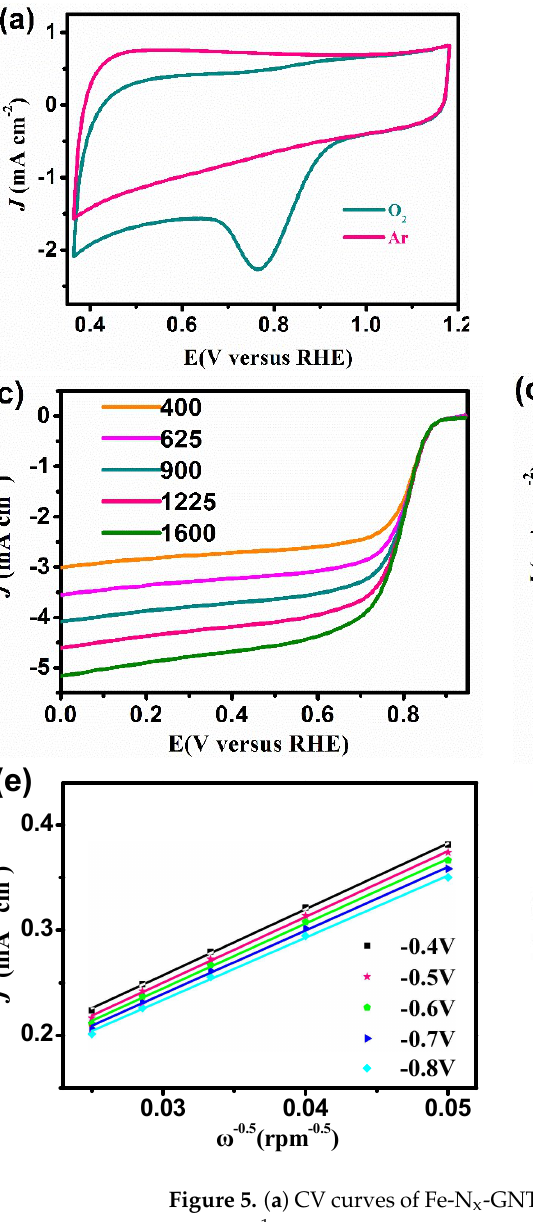
Figure 5. ( a ) CV curves of Fe-N x -GNT-2-1000 in Ar, O 2 -saturated 0.1 M KOH solution at a scan rate of 10 mV s − 1 . ( b ) LSV curves of Fe-N x -GNT-800, Fe-N x -GNT-900, Fe-N x -GNT-1000, Fe-N x -GNT-2-1000 and Pt/C 20% in O 2 -saturated 0.1 M KOH solution at a scanning rate of 10 mV s − 1 with 1600 rpm. ( c ) LSV curves for Fe-N x -GNT-2-1000 in O 2 -saturated 0.1 M KOH solution at a scanning rate of 10 mV s − 1 at different rotation speeds. ( d ) LSV curves of Fe-N x -GNT-2-1000 before and after cycling for 2000 cycles with a rotation rate of 1600 rpm. ( e )K–L plots for the ORR in O 2 -saturated 0.1 M KOH solution for Fe-N x -GNT-2-1000. ( f ) The durability test of Fe-N x -GNT-2-1000 and Pt/C for methanol. The catalyst loading is 0.6 mg cm −2 in all cases.